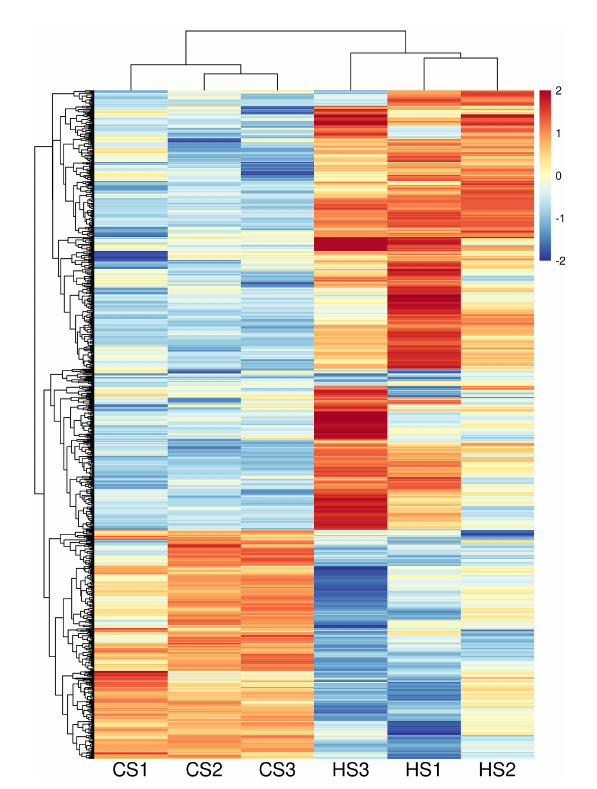
FIGURE 1 Heatmap of DEGs between CS and HS with FDR < 0.005 and fold change > 2.